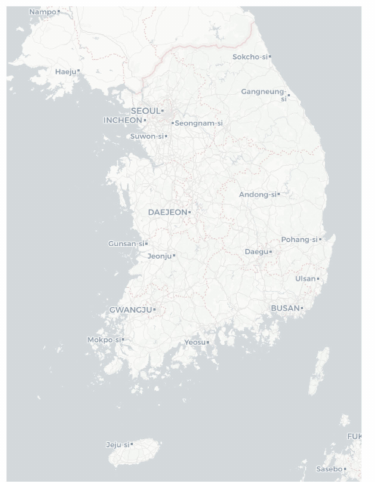
Figure 6. Study area.